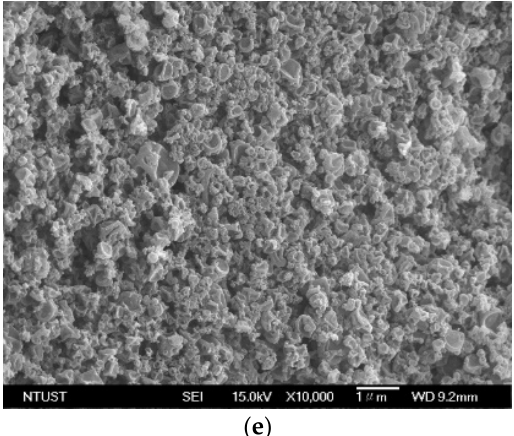
Figure 1. FESEM images of the HP- β -CD particles produced using the SAA process at different ethanol content of the HP- β -CD solution (EtOH%, w/w ): ( a ) 0%; ( b ) 44.1%; ( c ) 54.2%; ( d ) 70.3%; and ( e ) 100%.